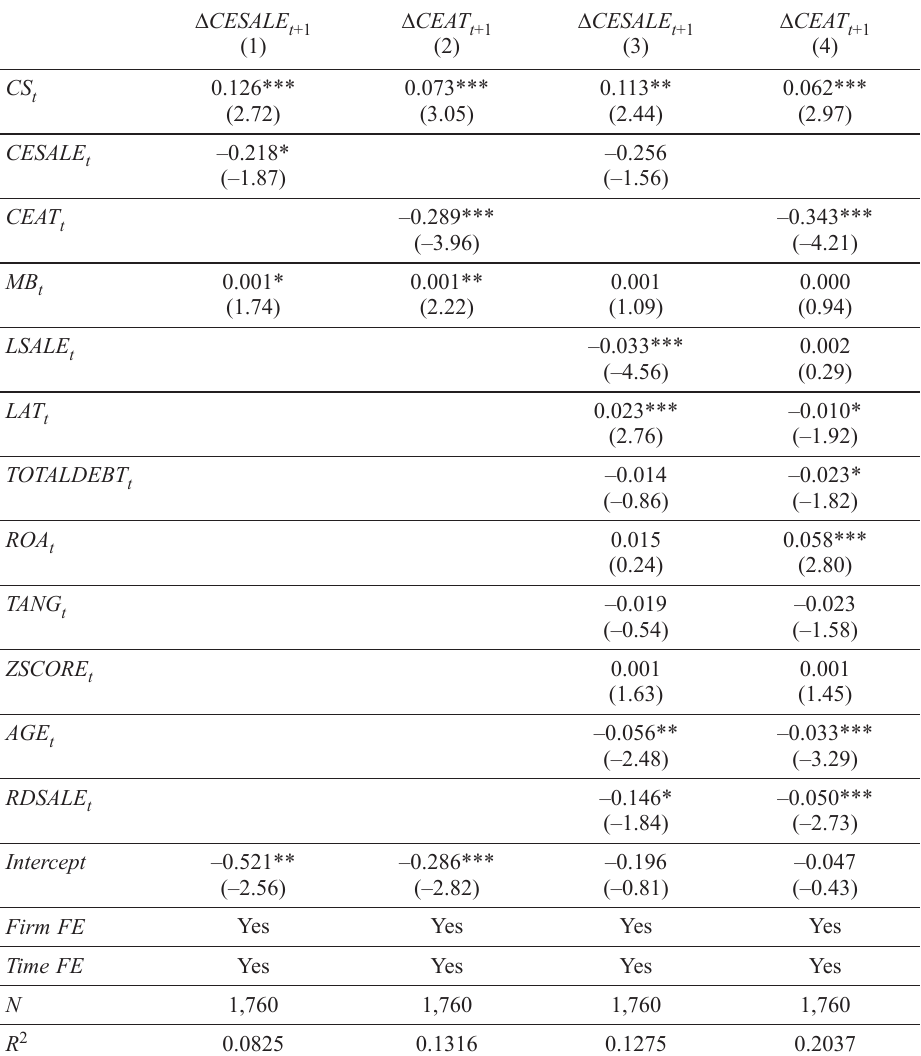
Table 2a. One-year period, customer satisfaction and capital